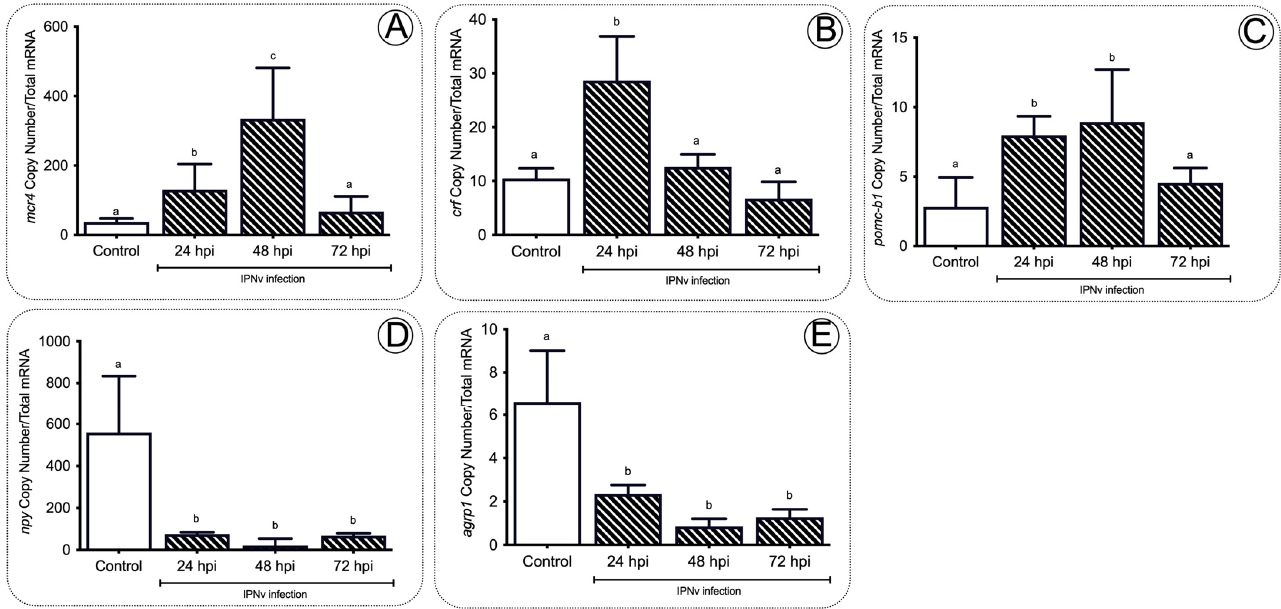
Figure 6. Anorexic and orexigenic gene expression profiles in the brain of salmon during infection. The mc4r ( A ), crf ( B ), pomcb ( C ), npy ( D ), and agrp1 ( E ) gene expression after IPNv infection on salmon brain tissue. Control sample corresponded to unchallenged fish. Data represent the mean ± SEM. One-way ANOVA; p < 0.05 was considered statistically significant. Different letters denote significant differences.